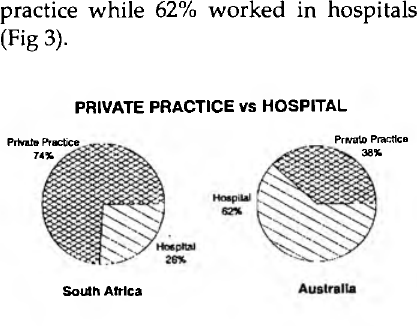
Fig 3: A comparison of the Universities of the Witwaters-